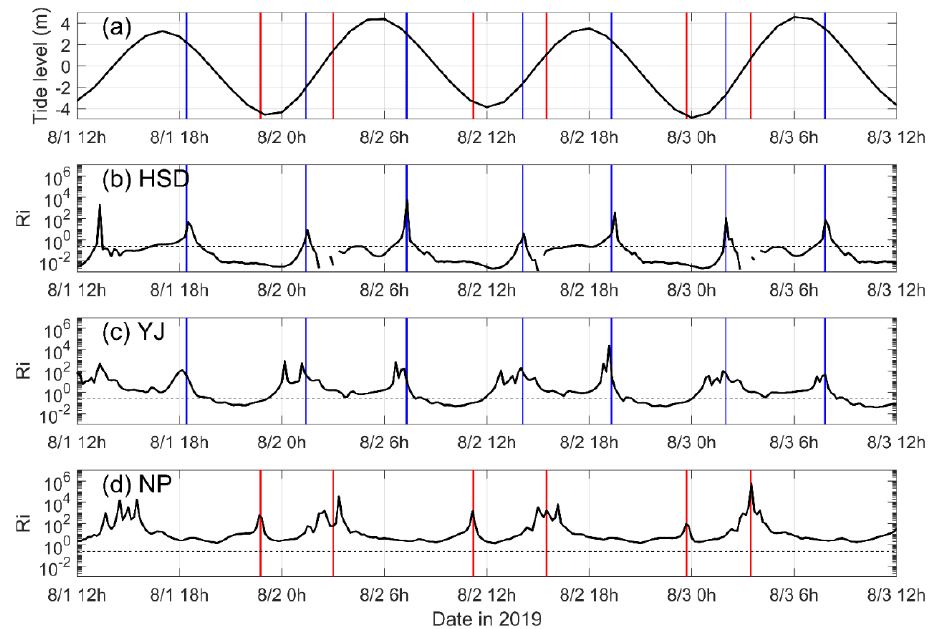
Figure 9. ( a ) Tide at T3, and Richardson numbers at ( b ) HSD; ( c ) YJ; and ( d ) NP, calculated from the model result (see Figure 1 for the locations). HSD and YJ are sited in the main channel while NP is in the port.